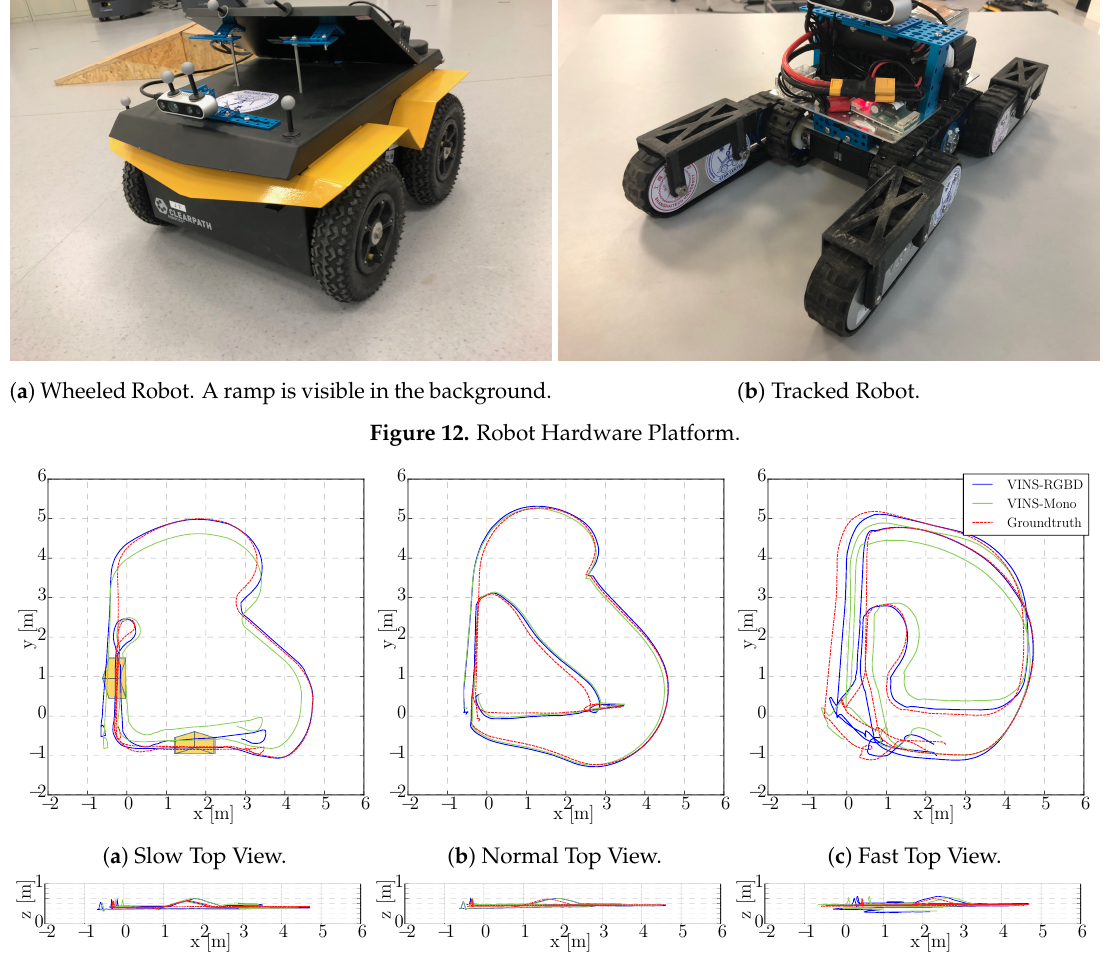
Figure 13. Wheeled Robot trajectory estimation. Driving on flat ground with two ramps (approximate position indicated in ( a ). ( b , c ) are